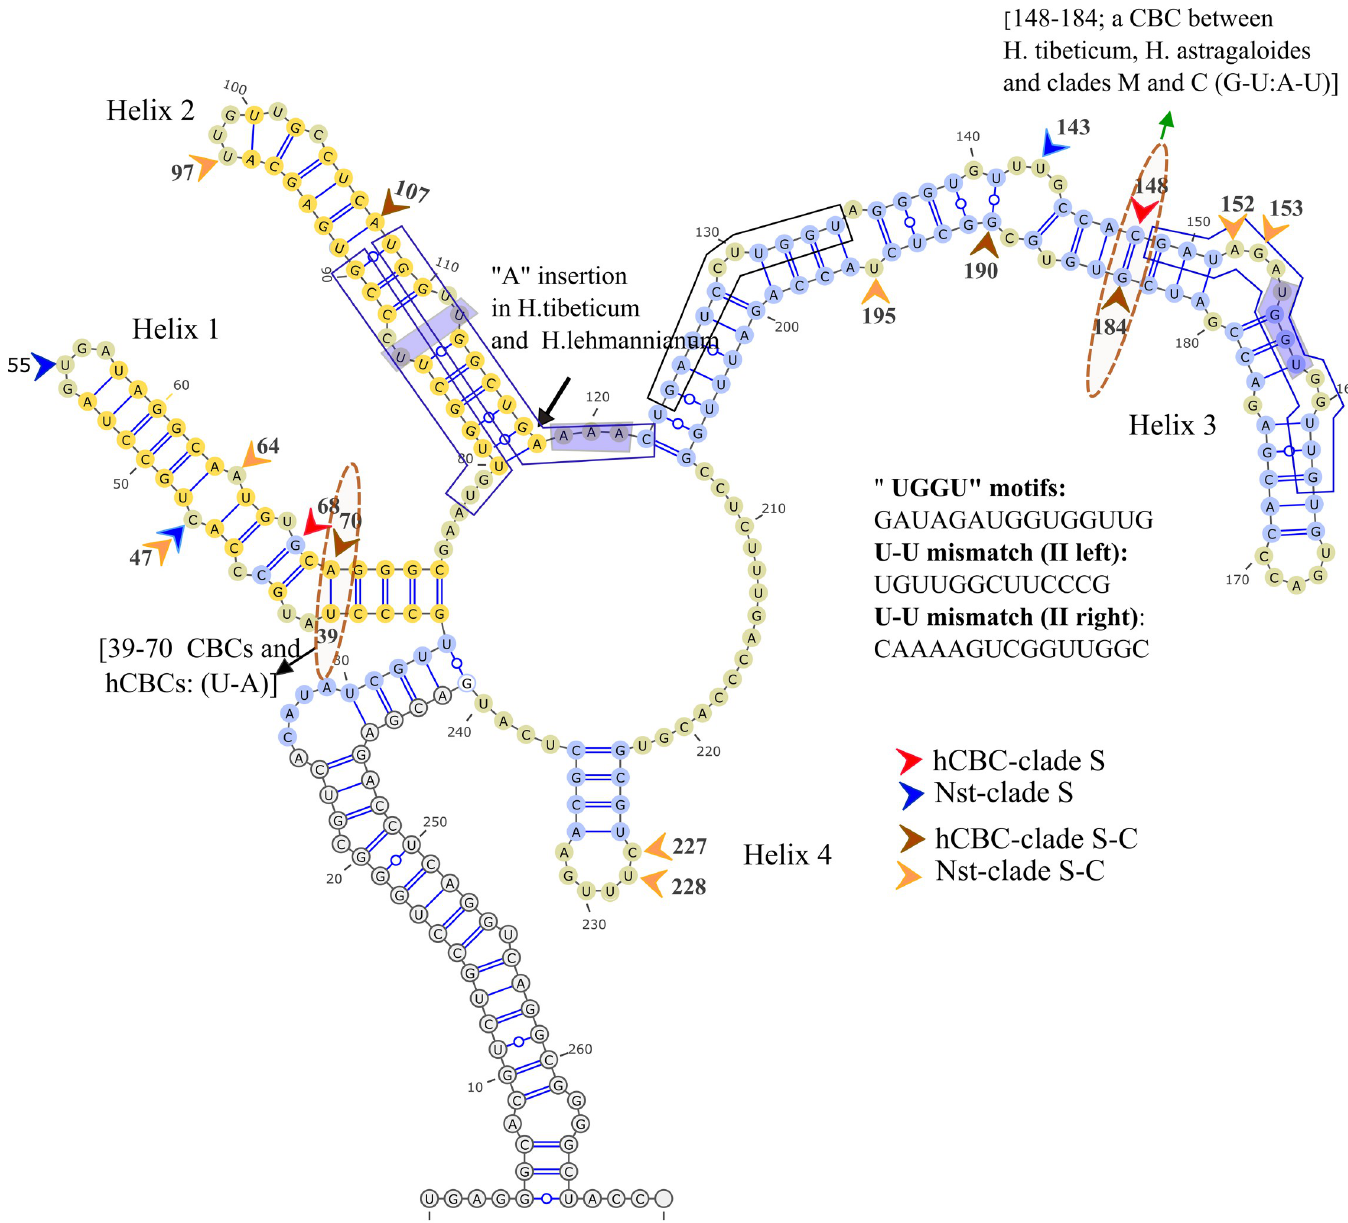
Fig 7. ITS2 Consensus secondary structure of H . sect. Stracheya (clade S). Yellow flashes 100% conserved regions in the